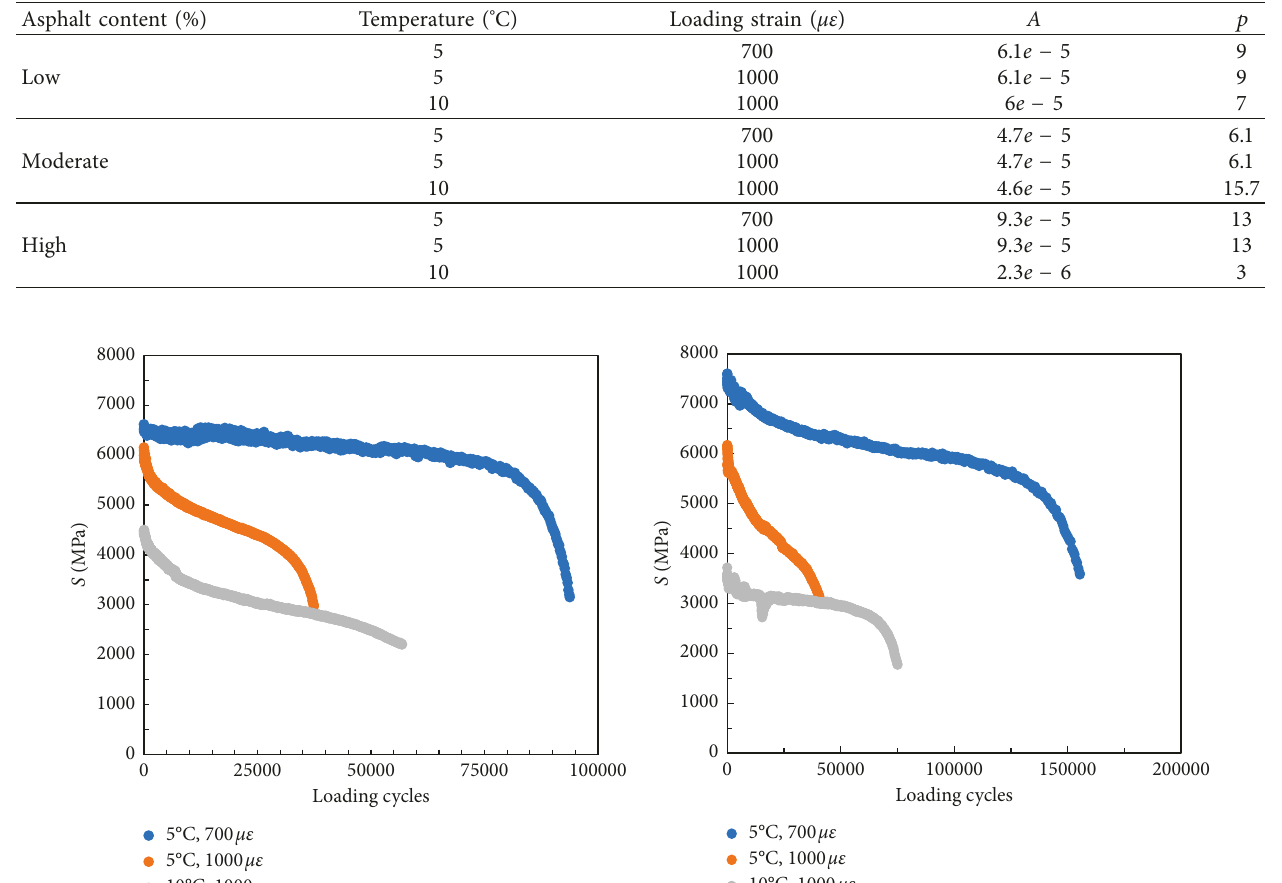
Table 4: Fitting parameters of the proposed damage evolution model under different